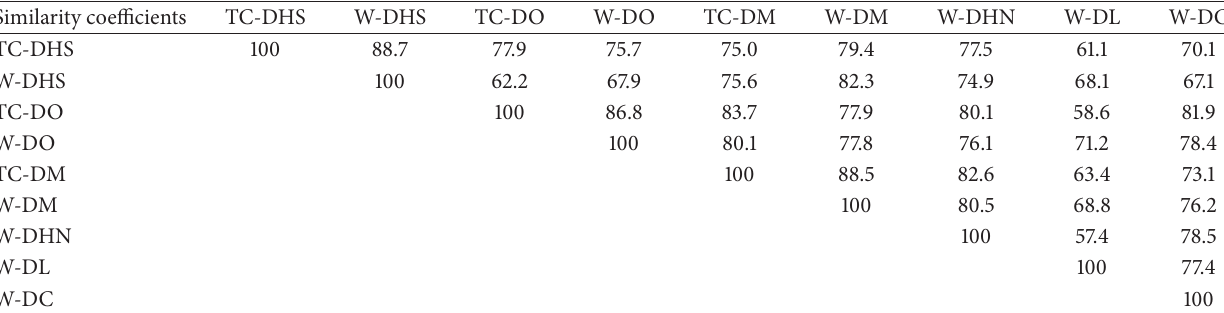
Table 5: The similarity coefficients of the FTIR of the polysaccharides from the nine dendrobiumsin the ranges of 4000–400 cm −1 (%). Similarity